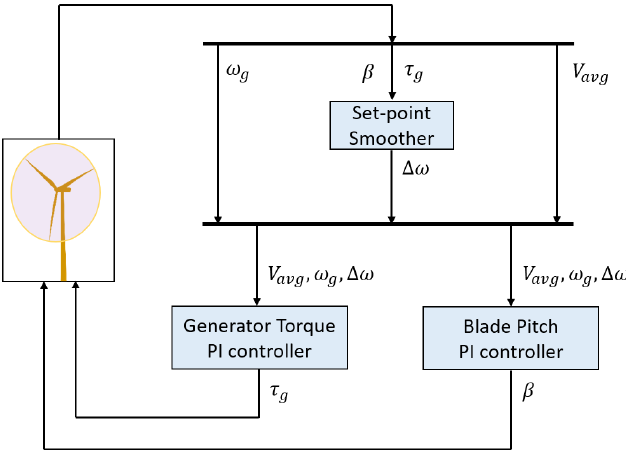
Figure 3. Block diagram of